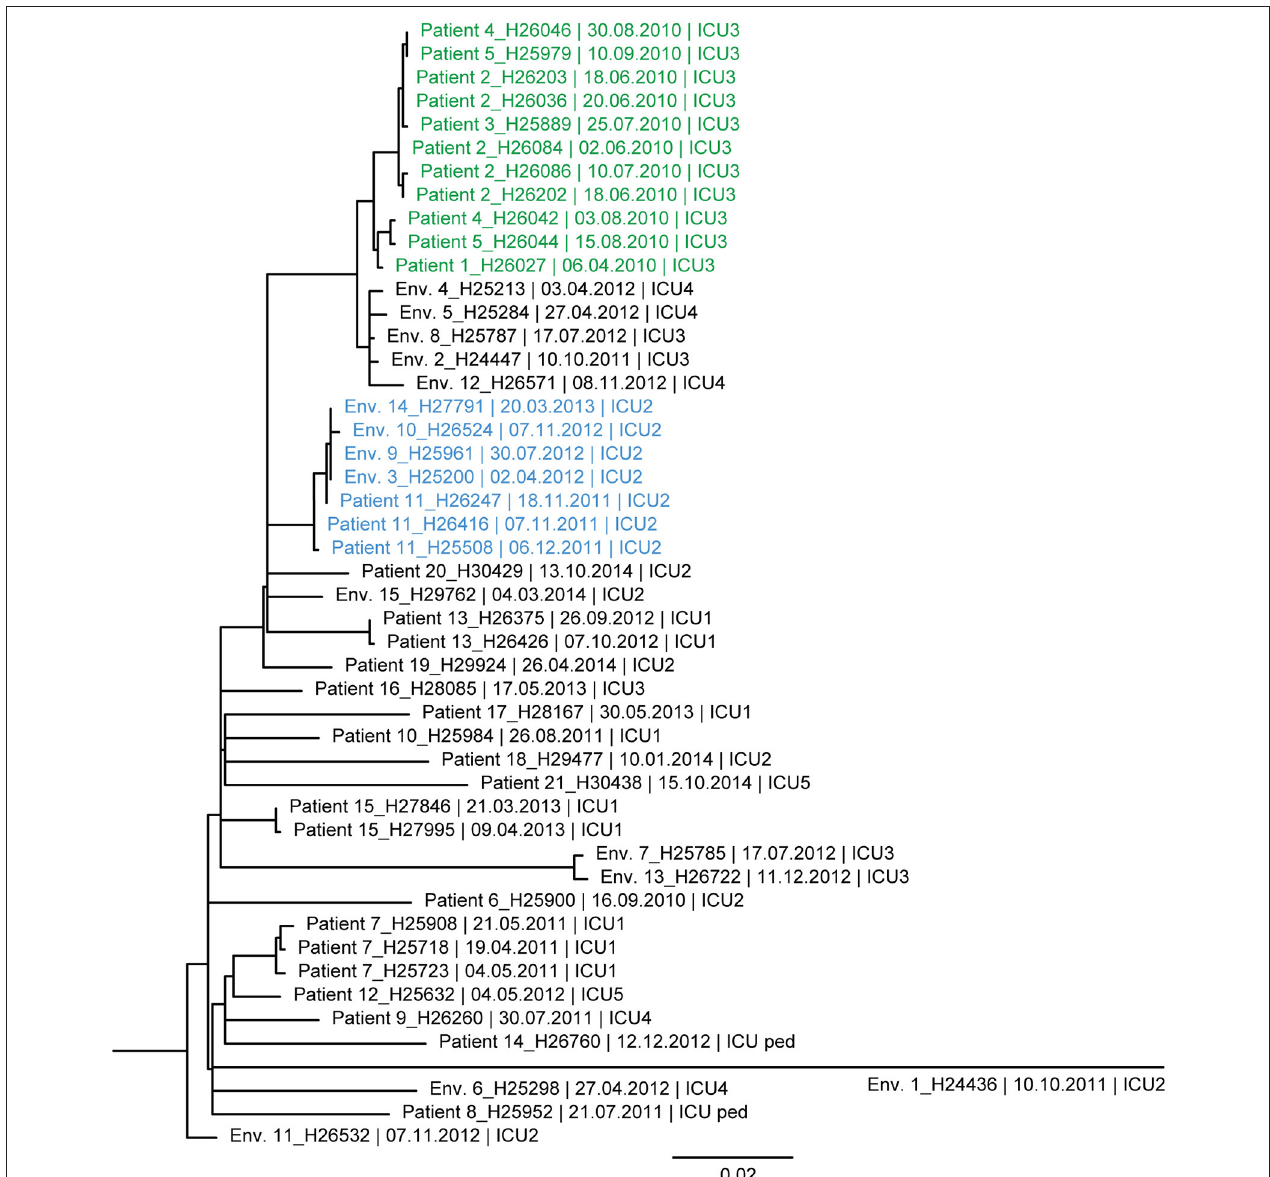
FIGURE 4 | Maximum likelihood tree based on SNP variable sites of all DLST 6–7 isolates. Isolate identification (patient or environment), date and unit of sampling are indicated. A subclade of isolates suspected to be epidemiologically linked in the burn unit is colored in green (0–13 SNP differences). A second subclade, in blue, is composed of isolates from Patient 11 and environmental isolates retrieved in ICU2 (0–7 SNP